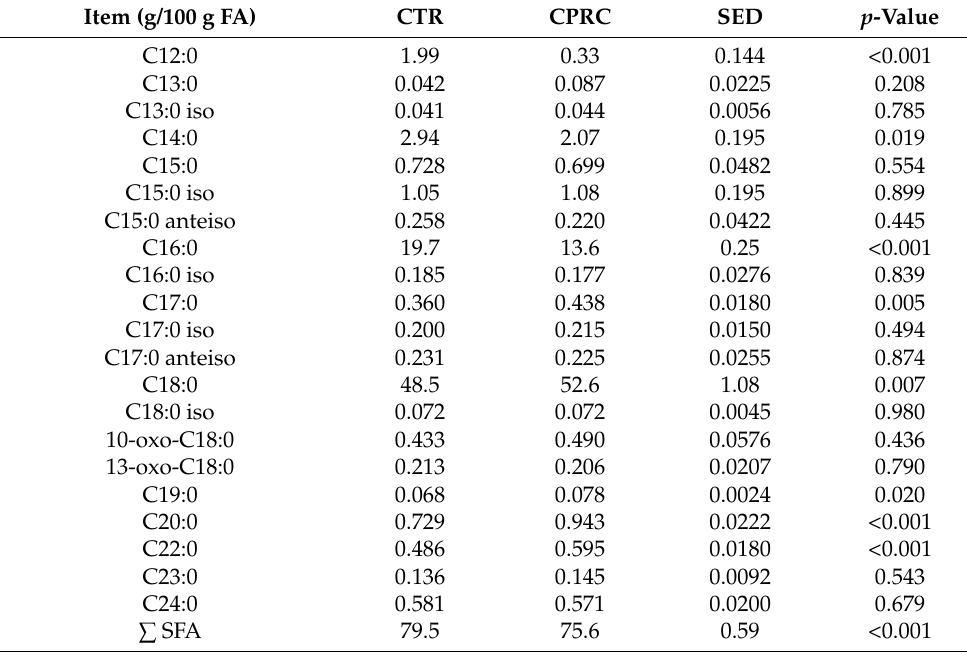
Table 3. Effect of including cold-pressed rapeseed cake in the concentrate of dairy cows on ruminal saturated fatty acid composition (LSM, n =